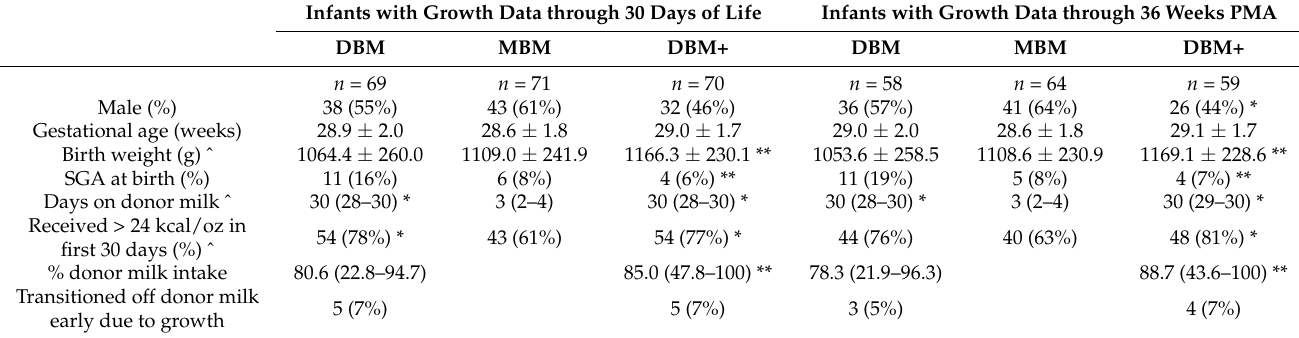
Figure 1. Flow diagram of study infants by cohort. Feeding protocol deviations included delays in advancing volumes, prolonged use of donor milk, and faster advances due to ability to feed orally. Modified feeding plans included continuous delivery, prolonged NPO status of at least 7 days, and atypical formula exposure. Table 2. Infant characteristics by